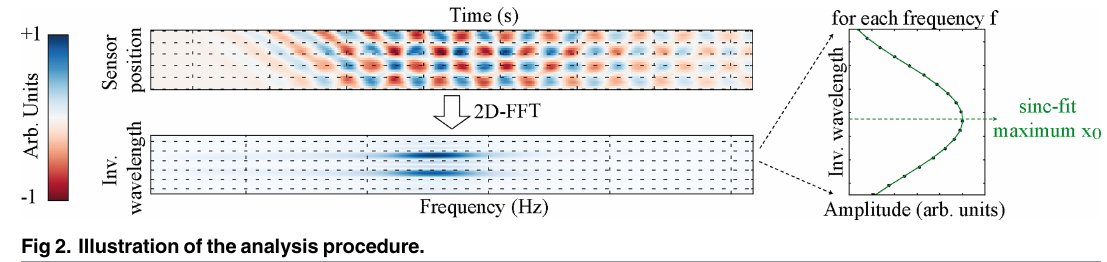
Fig 2. Illustration of the analysis